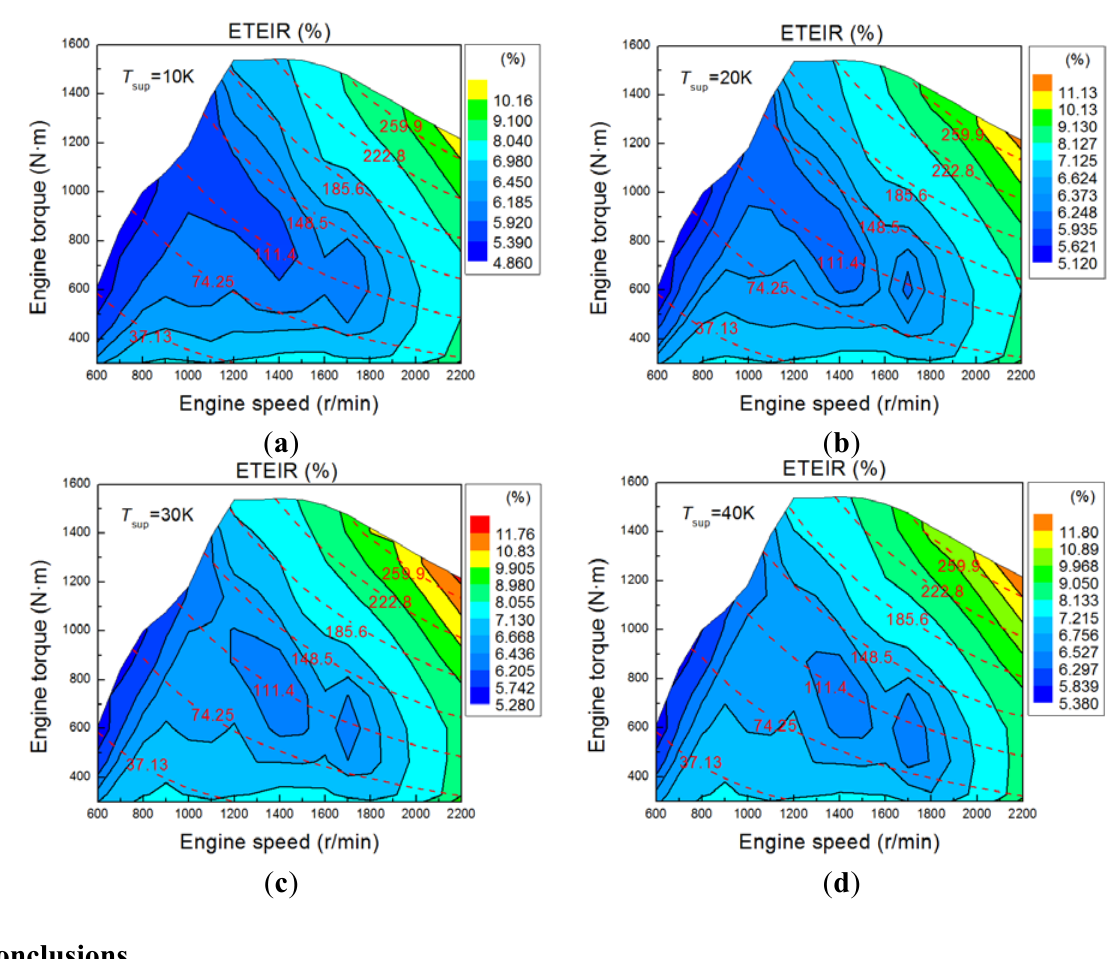
Figure 13. Engine thermal efficiency increasing ratio (ETEIR) of the ORC waste